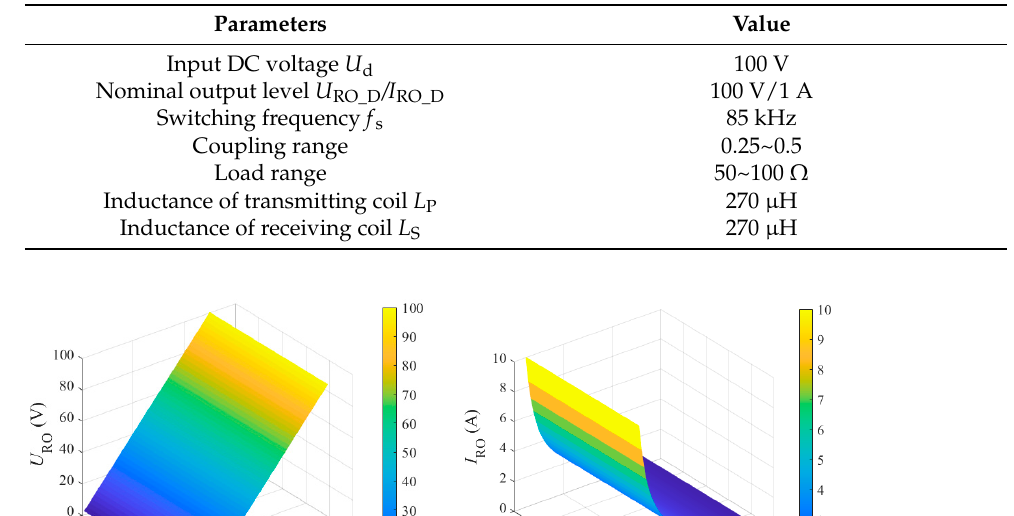
Table 1. Specifications of the IPT system.